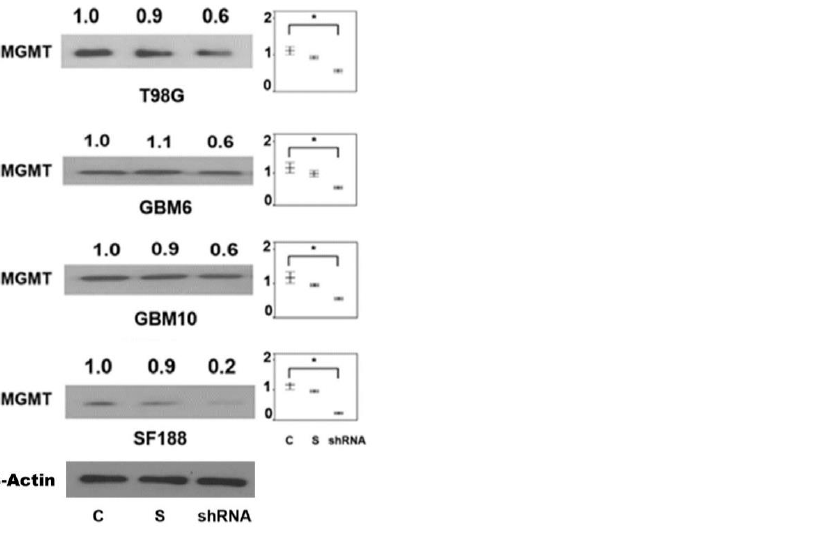
levels. As such, subtle changes in CTCF binding can result in activation or inhibition of